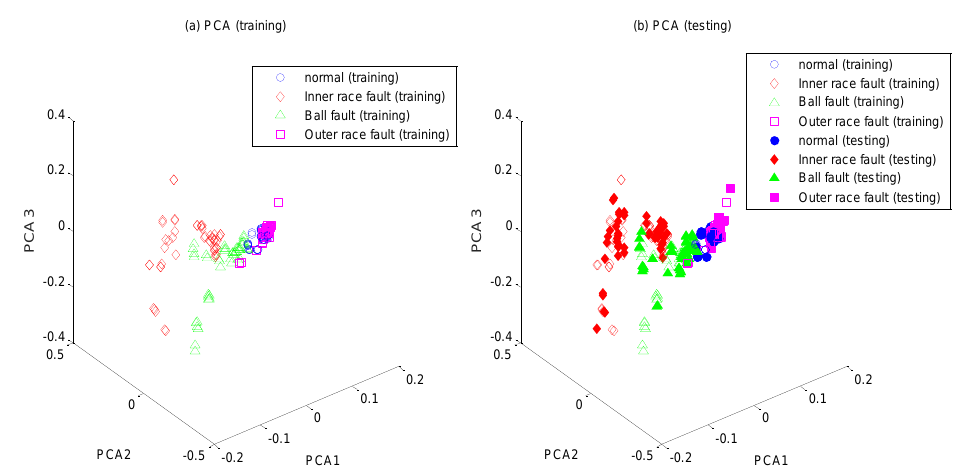
Figure 5. Feature extraction with PCA: ( a ) training samples, ( b ) testing samples.